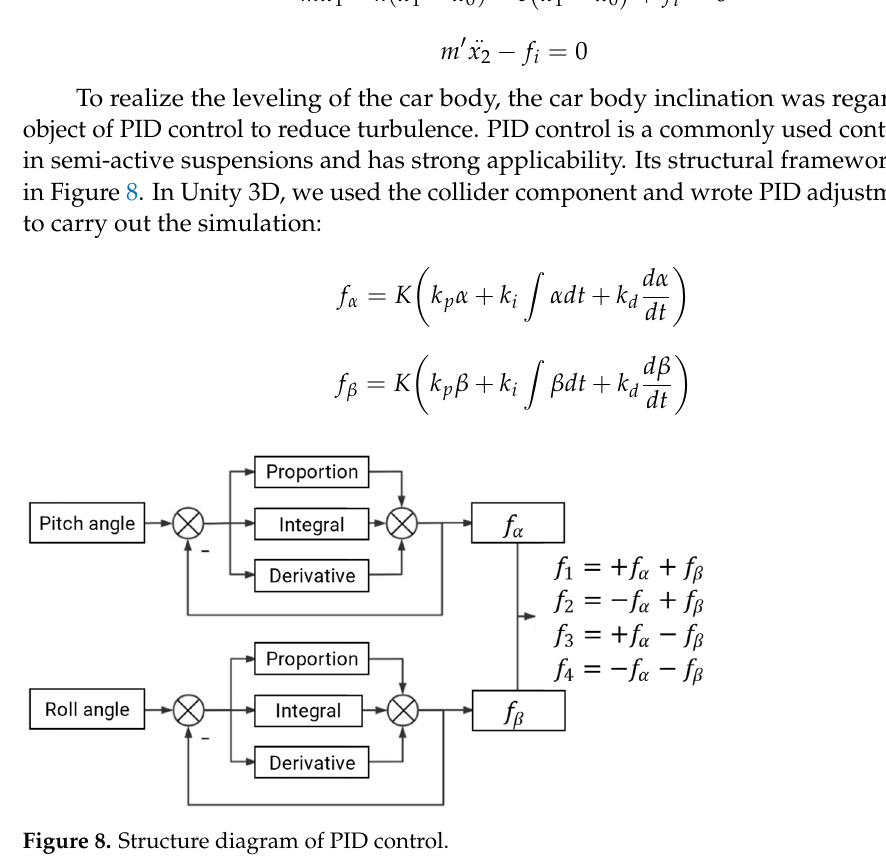
Figure 8. Structure diagram of PID control. 2.2.4. Virtual Sensors and Driving Warning